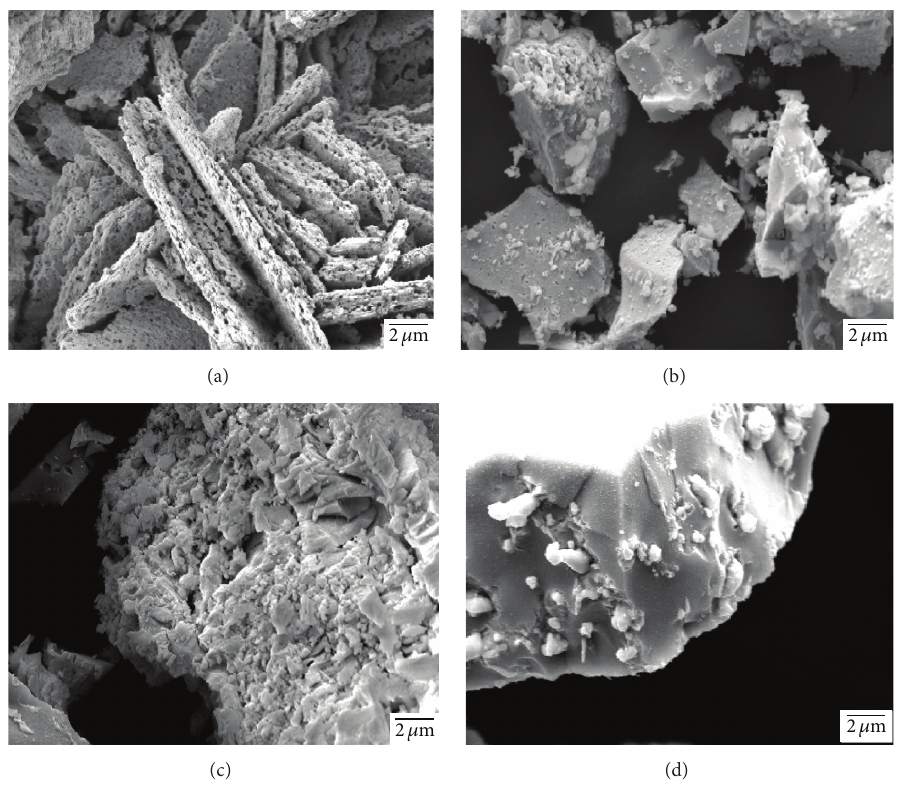
Figure 5: SEM images of samples prepared at (a) 200 ∘ C, (b) 400 ∘ C, (c) 600 ∘ C, and (d) 800 ∘ C (all images have same scale of 2 𝜇 m).